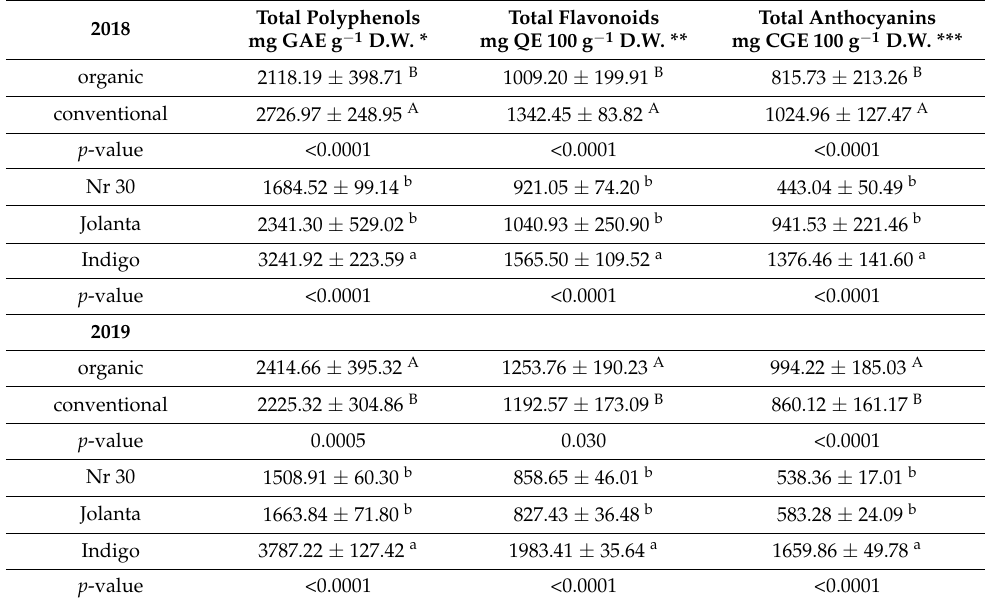
Table 1. The content of total polyphenols (by Folin–Ciocalteu method), total flavonoids (by Christ– Müller method), total anthocyanins (by Fulecki and Francis